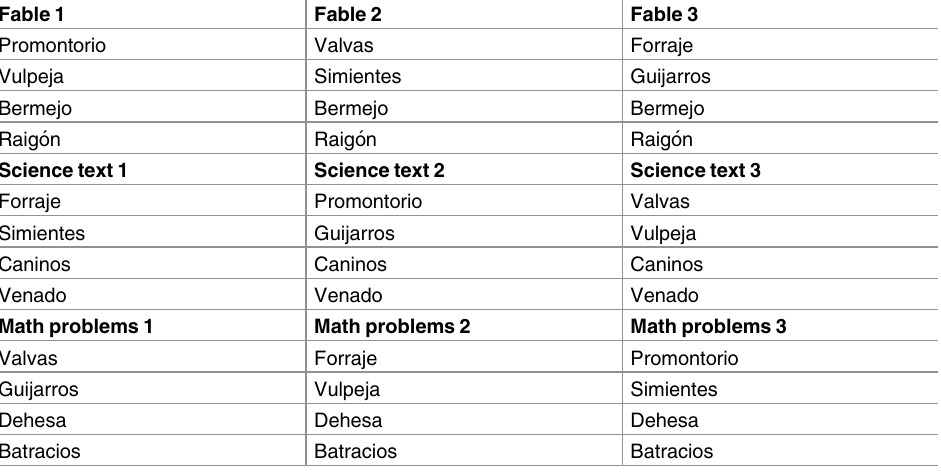
Table 2. Distribution of target words in the texts of the experimental set